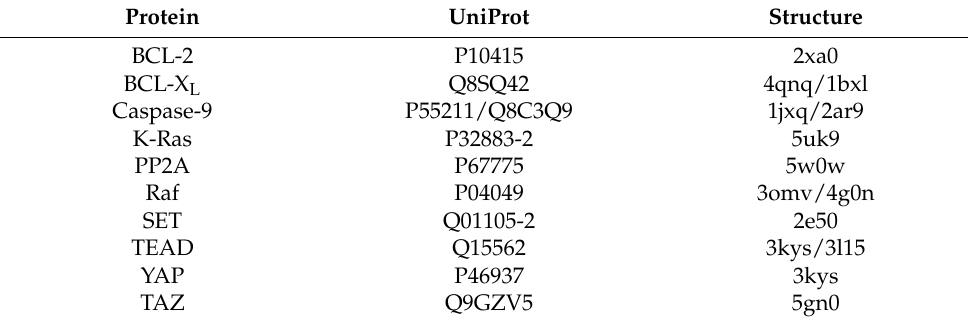
Table 1. UniProt and PDB identifiers of the